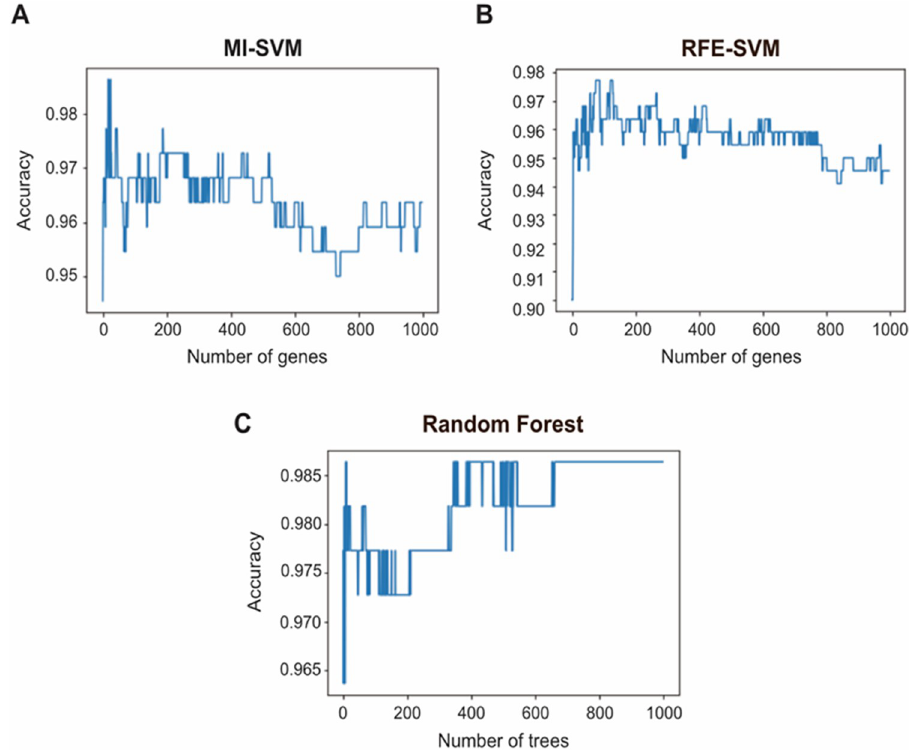
Fig 2. The incremental feature selection curves for the MI-SVM, RFE-SVM, and random forest models. The number of genes along with the corresponding SVM model weighted accuracy are shown (A and B) while the number of trees versus the RF achieved accuracy is shown in (C). (A) The peak of the curve is achieved at 19 genes with an accuracy of 98.64%. (B) The peak of the curve is achieved at 76 genes with an accuracy of 97.73%. (C) Utilizing 345 trees, the random forest model identified 1261 features and achieved an accuracy of